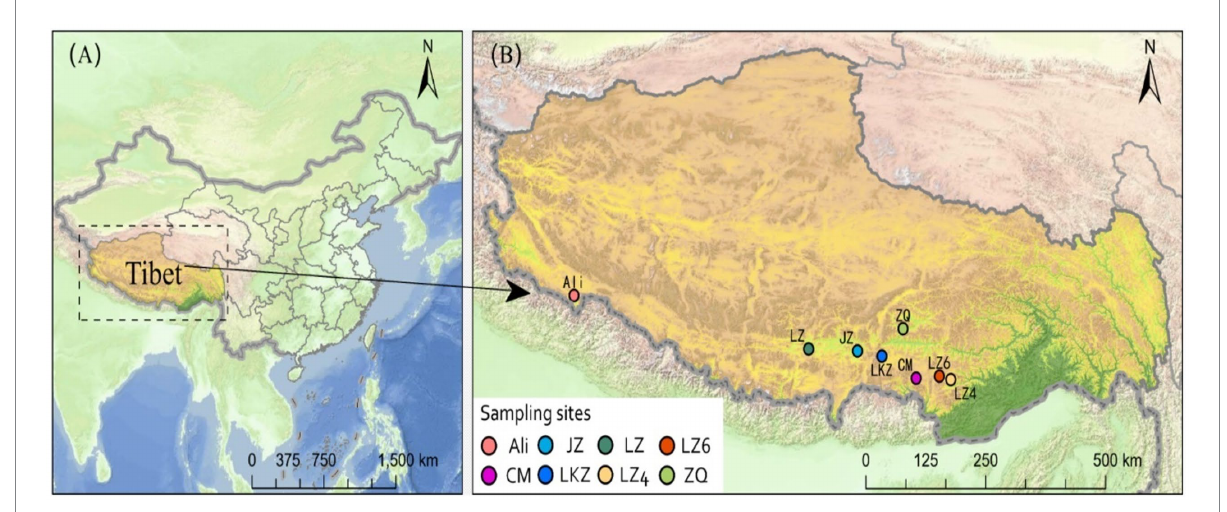
FIGURE 1 The locations of sampling sites of the eight highland barley varieties in Tibet Autonomous Region, China. CM, Cuomei; JZ, Jiangzi; LZ, Lazi; LZ4, Longzi4ling; LZ6, Longzi6ling; LKZ, Langkazi; and ZQ, Zangqing